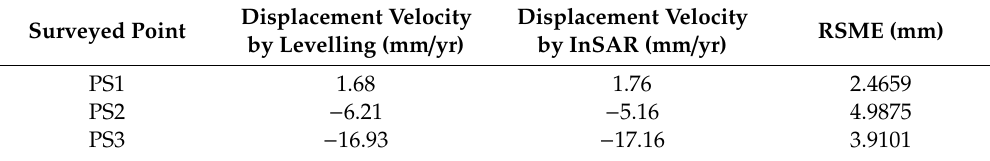
Table 4. Quantitative analysis of the comparison between InSAR and levelling for the three PS in the